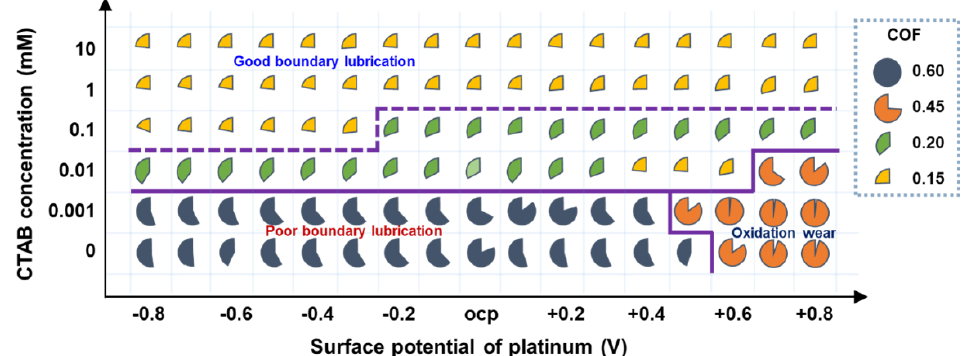
Fig. 9 Friction map of Pt/ZrO 2 tribo-pairs lubricated with different concentrations of CTAB aqueous solutions under different surface